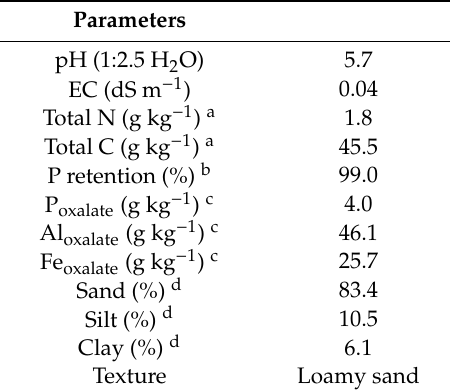
Table 1. Physicochemical properties of